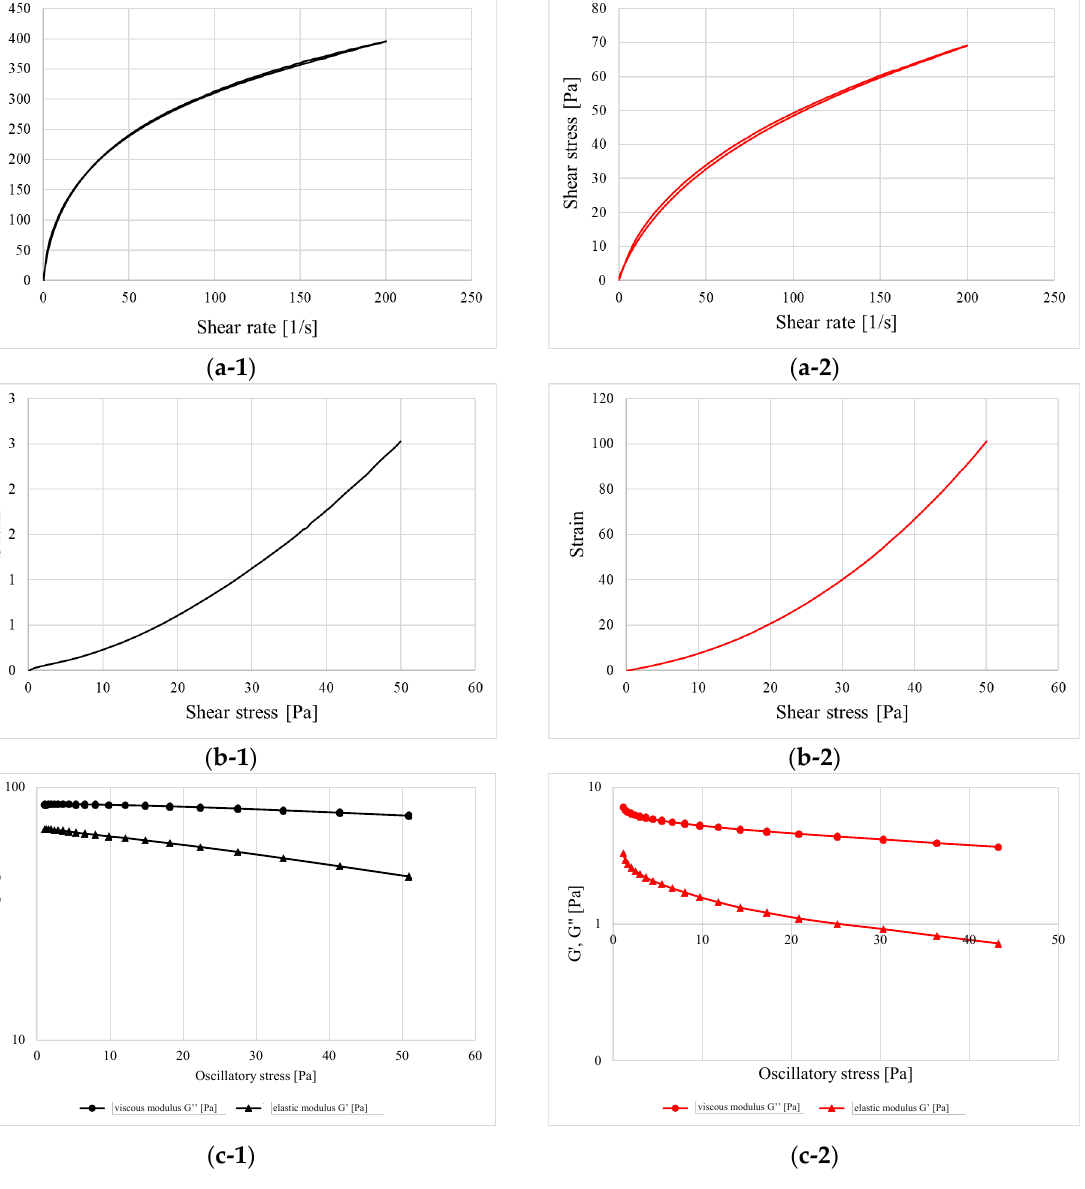
Figure 3. Flow curves obtained in controlled rate (CR) mode ( a-1 , a-2 ), flow curves obtained in controlled stress (CS) mode ( b-1 , b-2 ) and the oscillatory stress sweeping ( c-1 , c-2 ) for formulation 1 (black) and 2 (red). Table 5. The calculated rheological parameters from the course of the flow-curves.